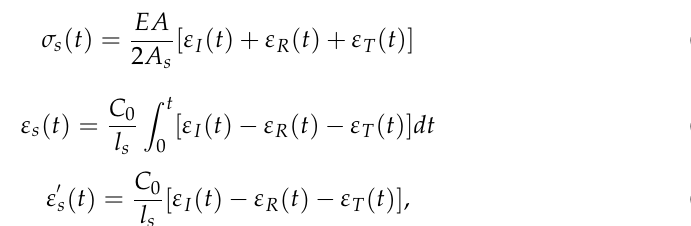
Table 6. Experimental scheme of dynamic compression